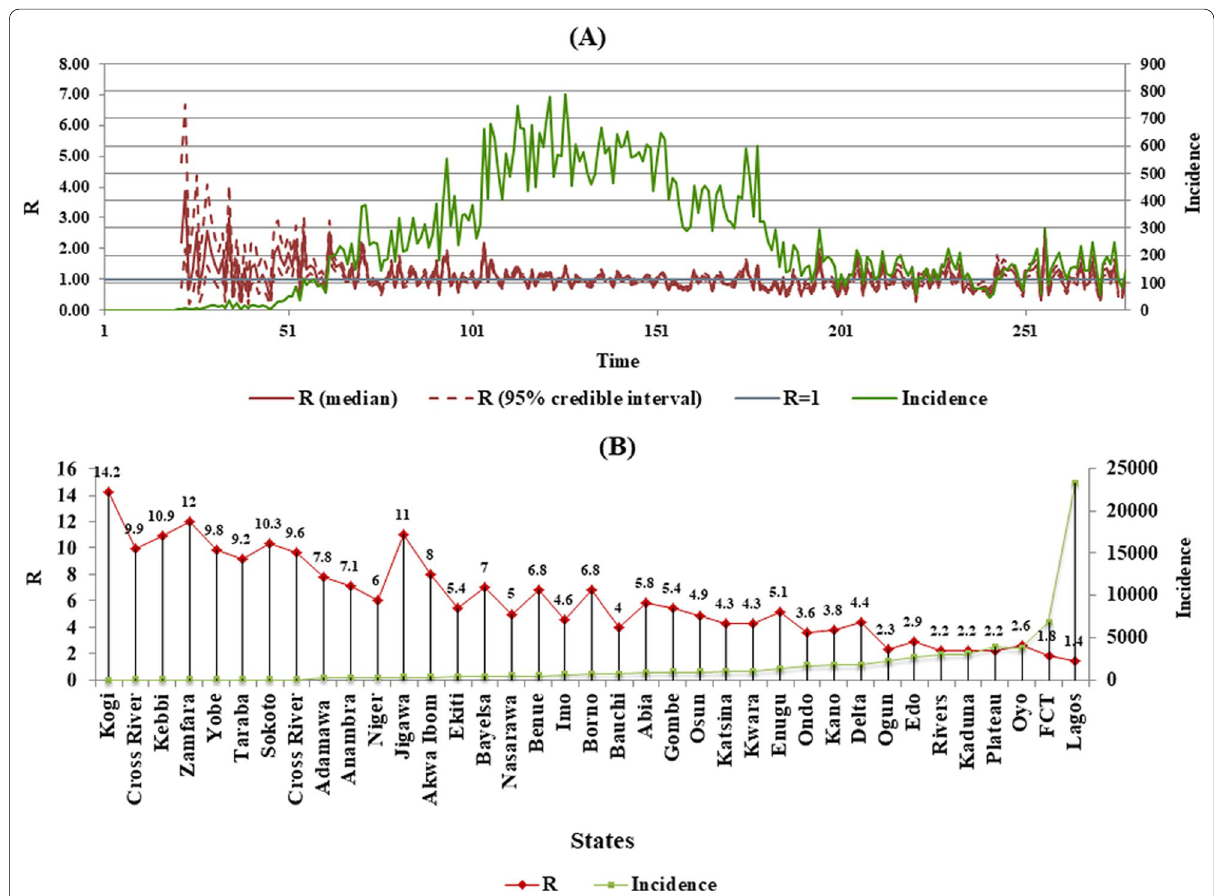
Fig. 3 Instantaneous reproduction number ( R ) of SARS-CoV-2 in Nigeria: ( a ), R averaged over 278 days in Nigeria (Posterior median and 95% credible interval). ( b ), R for each of the 36 states and Federal Capital Territory (FCT) Abuja (95% credible